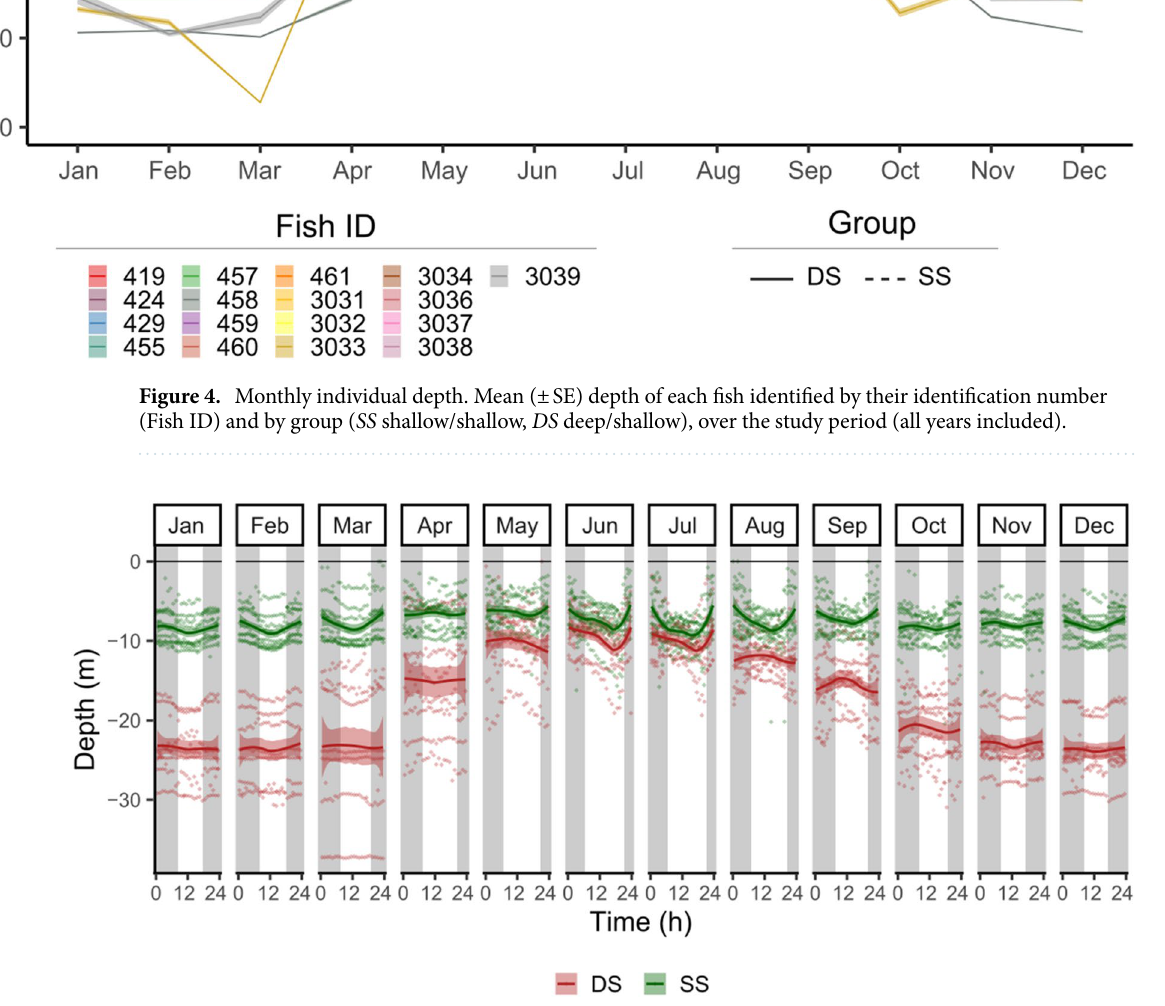
Figure 5. Variation pattern of daily and seasonal vertical movements. Each point is the hourly mean depth of each fish, identified by group ( SS shallow/shallow, DS deep/shallow). Lines represent Locally Weighted Least Squares Regression (LOESS) fit model. White and grey areas represent day and night periods,